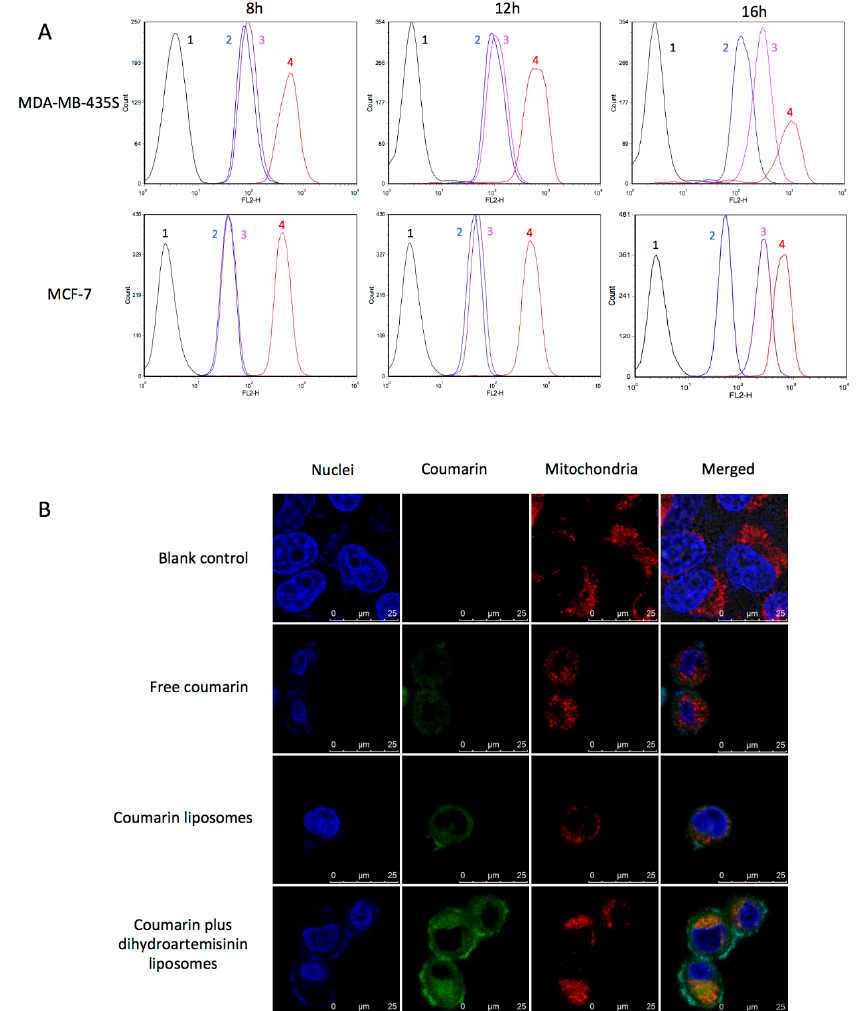
Figure 1. Cellular uptake and co-localization effects in breast cancer cells. ( A ) drug uptake measured by flow cytometry in breast cancer MDA-MB-435S and MCF-7 cells; ( B ) co-localization effect of fluorescent indicator coumarin with mitochondria observed by confocal microscope in breast cancer MCF-7 cells (scale bar = 25 µm). 1, blank medium; 2, epirubicin liposomes; 3, dihydroartemisinin plus epirubicin liposomes; 4, free epirubicin.